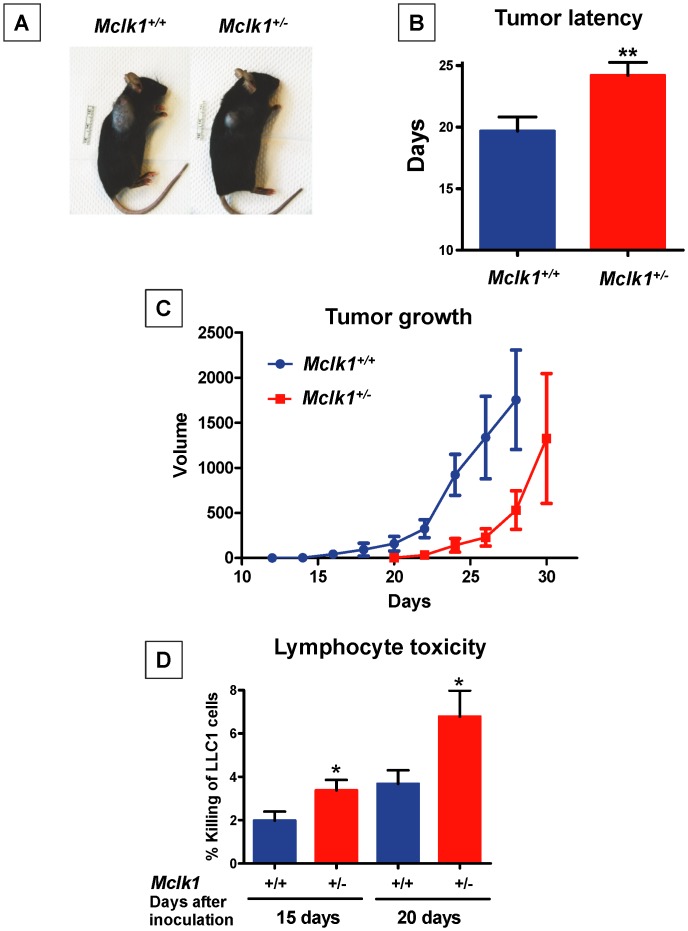
Direct evidence for altered tumorigenesis in the Mclk1
+/− mutants.
A. LLC1 mouse lung cancer cells were injected subcutaneously in the right supra-scapular area of 10-week-old Mclk1
+/− mutants (n = 19) and sibling controls (n = 18) in the C57BL/6J background at a dose of 104 cells/mouse. The time of first appearance of visible tumors was recorded and their growth subsequently followed. The panel illustrates tumor sizes on day 28 after inoculation. B. Average day of tumor appearance after grafting in both genotypes. The asterisks indicate significance at P<0.01 by a t-test. C. Tumor growth curves reveal again the difference in latency but also show similar growth rates once tumors have appeared. Data after day 28 are not available for tumors on wild type animals because these animals had to be humanely euthanized due to tumor size. D. Two cohorts of 8–12 mice for each genotype were used to measure splenic lymphocyte cytotoxicity against LLC1 cells in vitro after 15 and 20 days following inoculation. The mean ± S.E.M. of each group is shown. The asterisks indicate significance at p<0.05 by a t-test. All experiments in this figure were carried out with even numbers of both males and females.